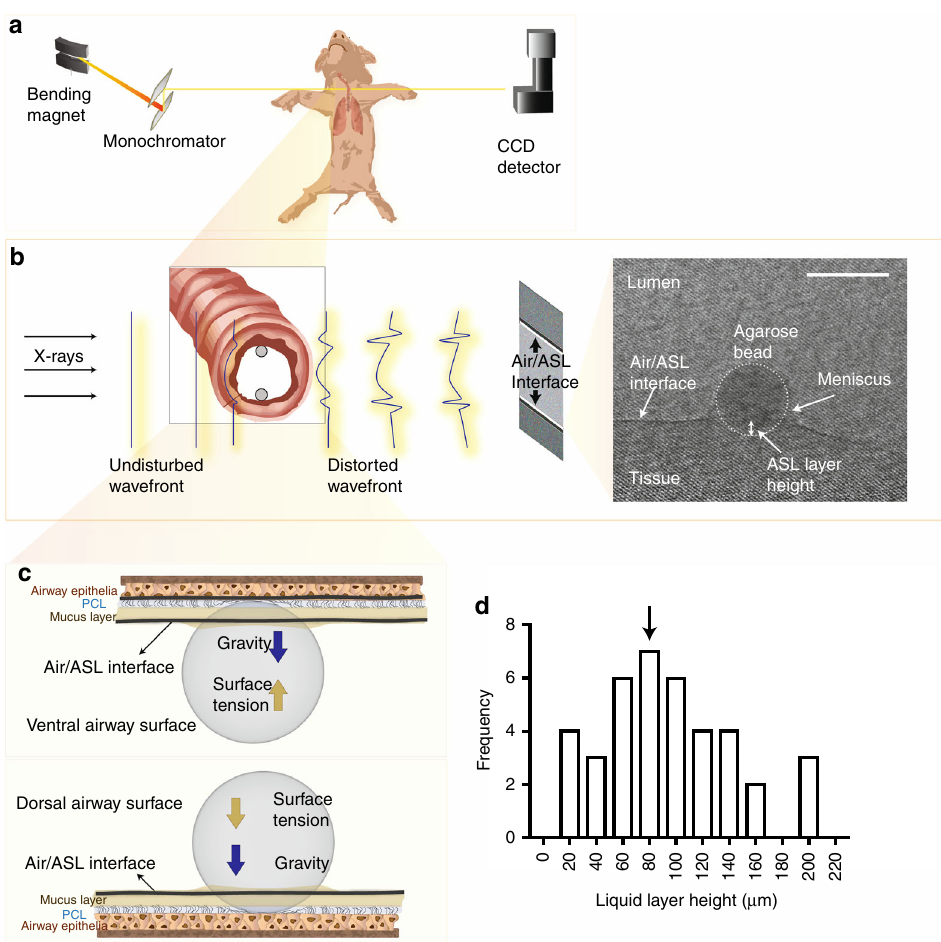
Fig. 1 Synchrotron-based phase contrast imaging. a Schematic of the in vivo imaging set up. b Detection of the air/ASL layer interface in the lumen of swine trachea in vivo. When x-ray (undisturbed wavefront) pass through the trachea, the difference in refractive index between the ASL and the air in the lumen results in a phase shift of the x-ray (distorted wavefront), which is detected by phase contrast imaging (PCI). PCI cannot resolve the ASL/tissue interface because the ASL refractive index is very similar to that of the tissue. Thus we used agarose beads as “ measuring rods ” to determine the position of the tissue with respect to the air/ASL interface. In the phase contrast image obtained in vivo (grayscale image on right panel ), the air/ASL interface is clearly observable as a dark line (highlighted with dotted line ). The edge of the agarose bead is outlined by the dotted circle . The distance from the bottom of the agarose bead to air/ASL interface is used to measure the height of the ASL layer. Note that the air/ASL interface is below the level of the meniscus formed by the ASL on the agarose bead. Scale bar represents 500 µ m. c Schematic diagram illustrating the forces acting on the agarose bead (surface tension and gravity) and the bead – tissue interaction. d Frequency distribution and mean (93 ± 8 µ m, indicated by arrow) of ASL height in wild-type swine trachea exposed to bacteria-free agarose beads in vivo ( n = 39 agarose beads obtained from 24 wild-type live